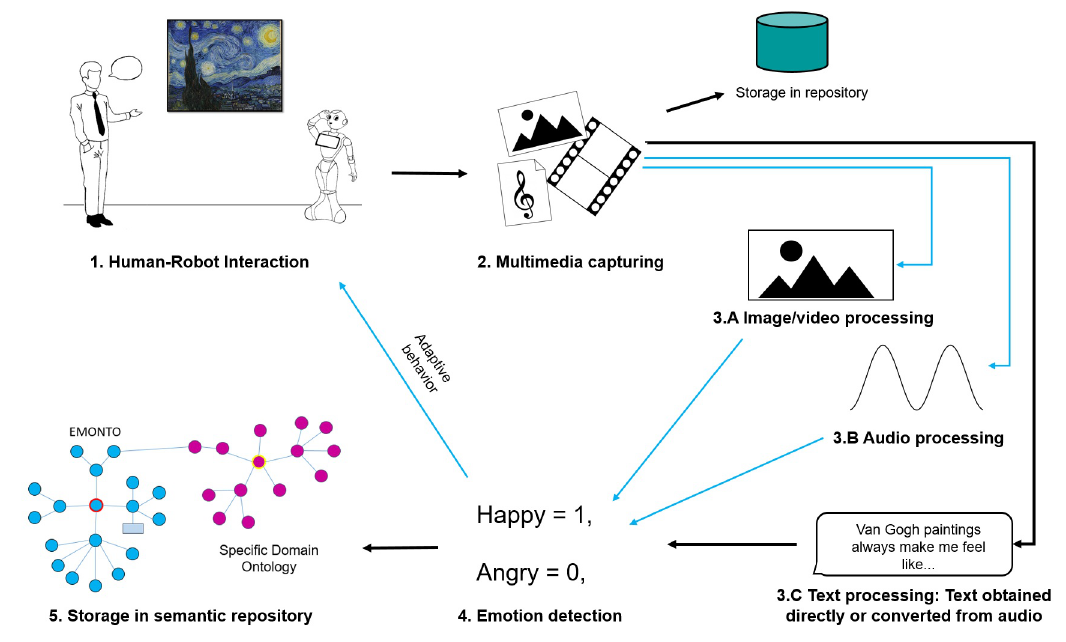
Figure 2. General overview of the